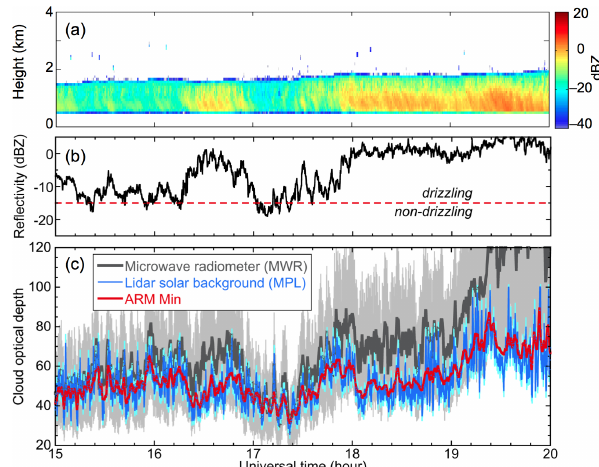
Figure 4. (a) Time series of radar reflectivity profiles on 10 April 2007. (b) Cloud-base reflectivity indicating the presence of driz- zle. (c) Time series of cloud optical depth retrieved from a mi- crowave radiometer (MWR), lidar solar background signals from micropulse lidar (MPL) and ARM Archive Min retrievals. Grey er- ror bars denote lower and upper limits for MWR values, correspond- ing to a change in droplet effective radius from 6 to 14µm. Note that AERONET cloud-mode observations were unavailable for this